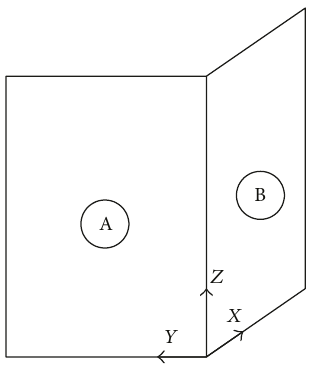
Figure 8: Definition of local coordinate